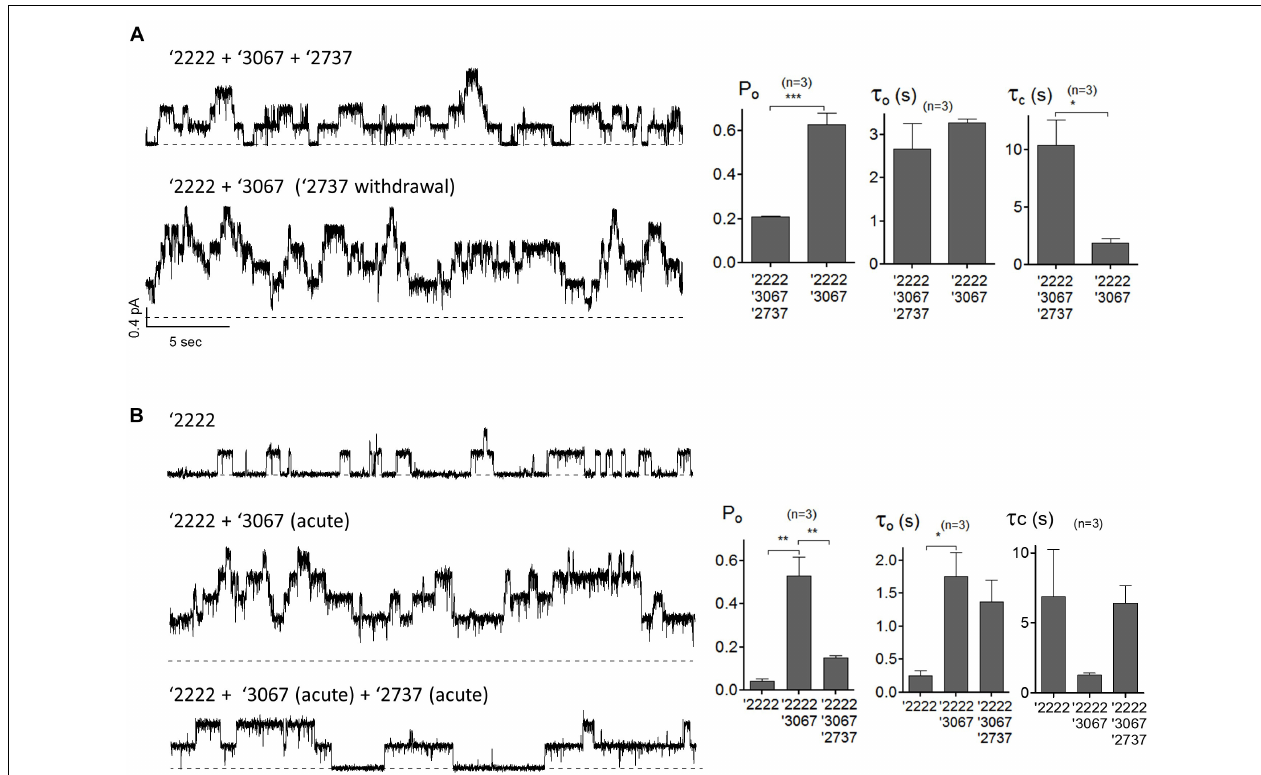
FIGURE 5 | Single-channel behaviors of F508del CFTR expressed in CHO cells pre-treated with corrector(s) GLPG2222, GLPG2737 and or potentiator GLPG3067. (A) Representative single-channel current traces of F508del CFTR in the presence of 0.5 µ M GLPG2222 + 10 µ M GLPG3067 + 1 µ M GLPG2737 (upper trace) and after washout of GLPG2737 (lower trace) from a cell pre-treated with 0.5 µ M GLPG2222 + 10 µ M GLPG3067 + 1 µ M GLPG2737. Kinetic parameters (Po, τ o , and τ c ) are shown on the right. (B) Representative single-channel current traces of F508del CFTR in the presence of 0.5 µ M GLPG2222 (upper panel), after addition of 10 µ M GLPG3067 (middle panel) and additional application of 1 µ M GLPG2737 (lower panel) from a cell pre-treated with 0.5 µ M GLPG2222. Kinetic parameters (Po, τ o , and τ c ) are shown on the right. The statistical analysis of single-channel kinetic parameters was described in “Materials and Methods” Section, every condition was tested at least three times. ∗ P < 0.05; ∗∗ P < 0.01; ∗∗∗ P < 0.005.